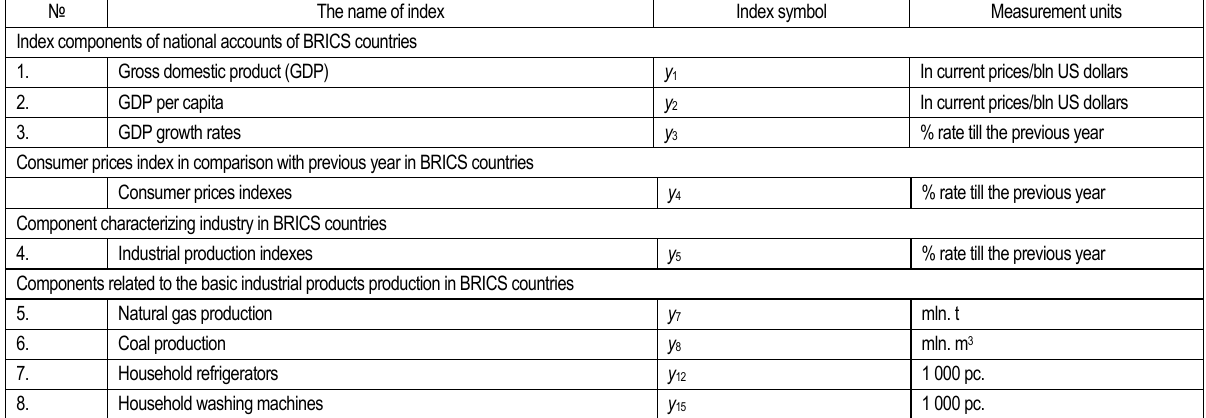
Table 2. Integration processes development system, the case of BRICS